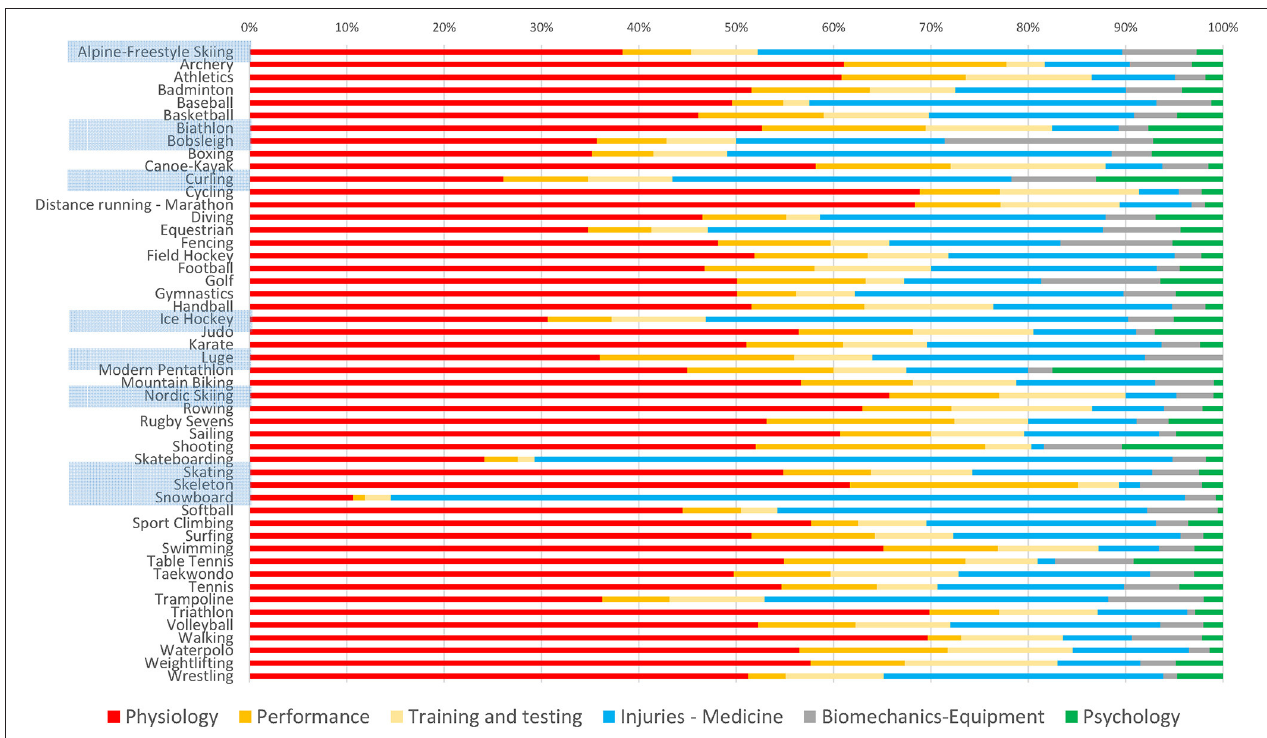
FIGURE 6 | Distribution of publications between six research topics across all summer and winter Olympic sports. Winter sports are highlighted.